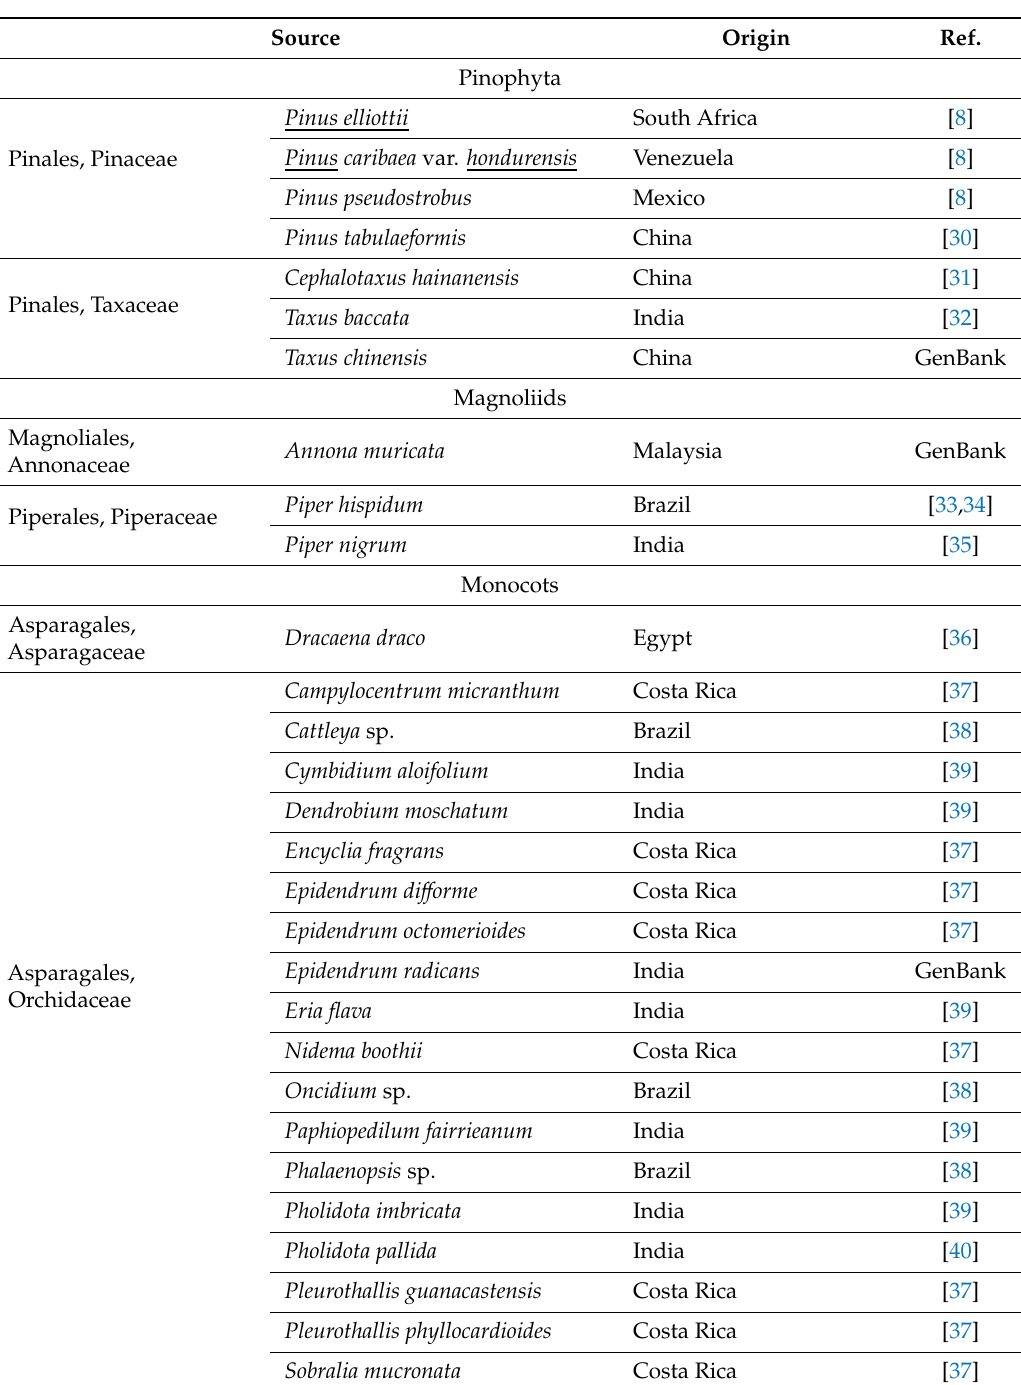
Table 1. Plant hosts of endophytic Lasiodiplodia theobromae . Species where the fungus has been also reported as a pathogen are